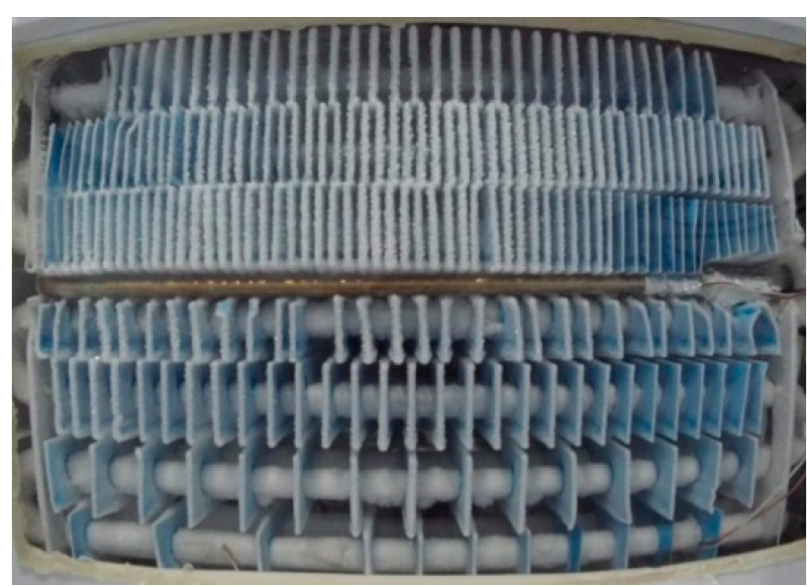
Figure 5. Frosting condition of the evaporator studied in this paper. Based on the original fin distribution, other three different fin distribution schemes are